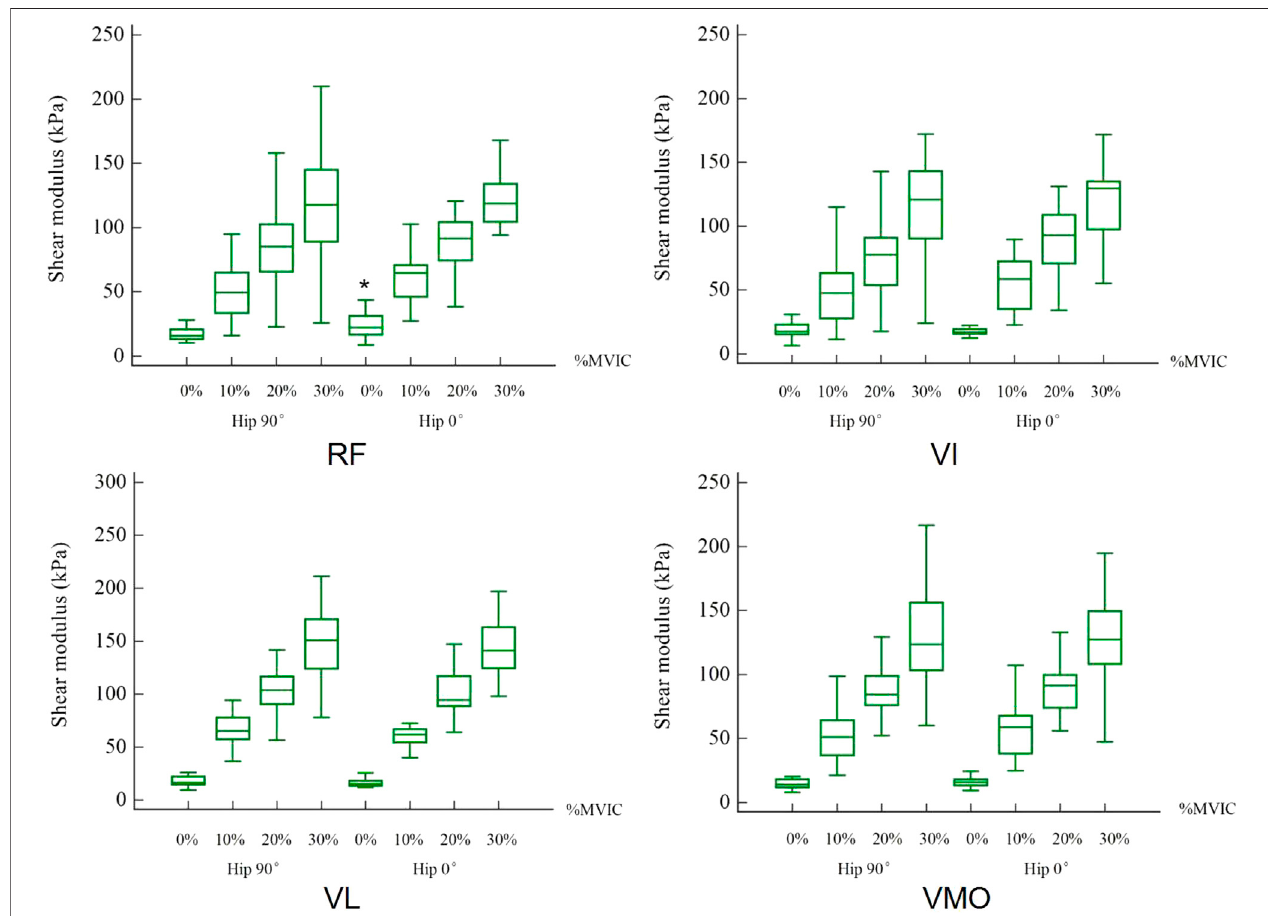
FIGURE 2 | Effects of hip angle on shear modulus of muscles. * means signi fi cant difference.